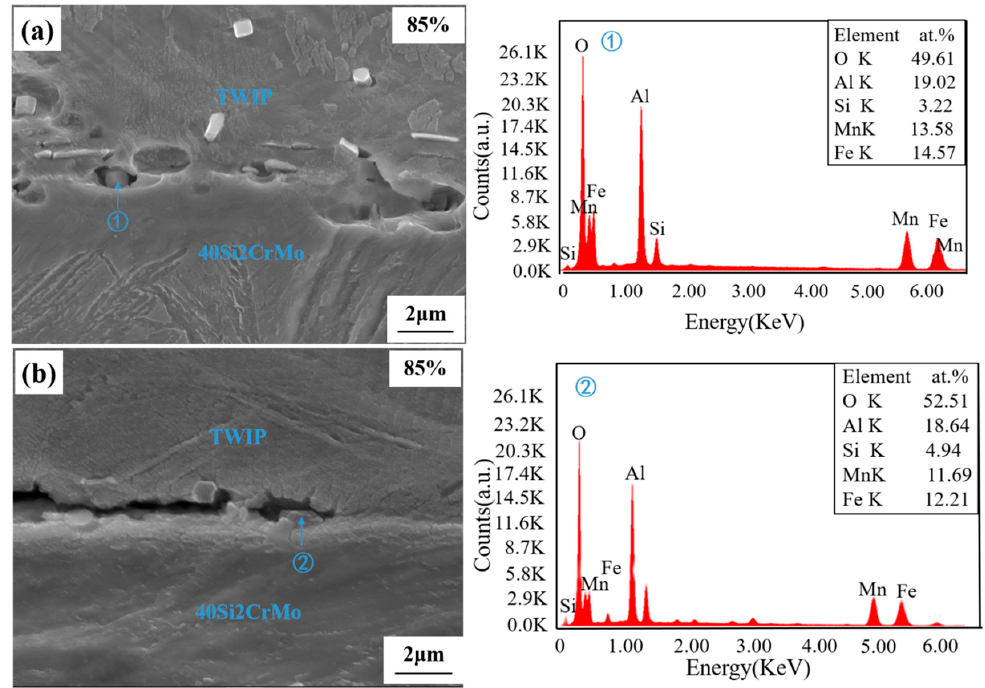
Figure 11. EDS spectra of multilayer steel with a hot rolling reduction of 80%: ( a ) before the tensile test; ( b ) after the tensile test.